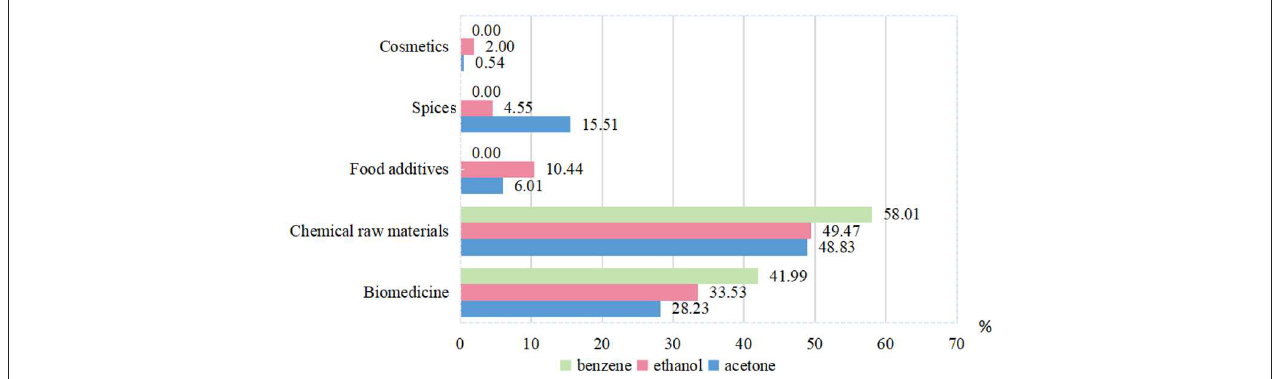
FIGURE 4 | Potential application based on thefunctional groups constitute of three solvents from C. camphora